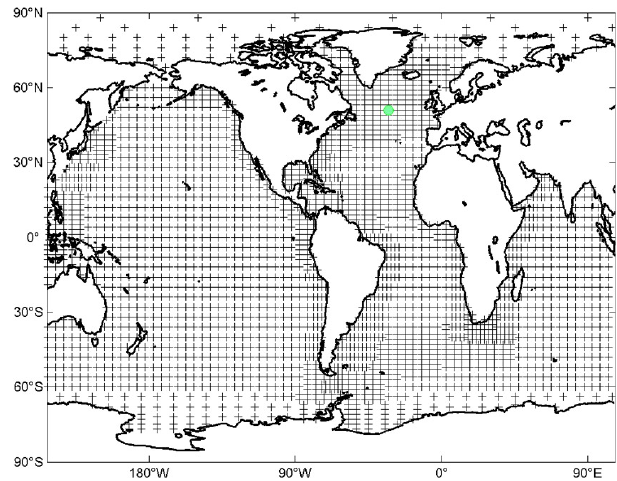
Fig. 3. Variable resolution model grid. The green circle indicates the position of the data in Fig.